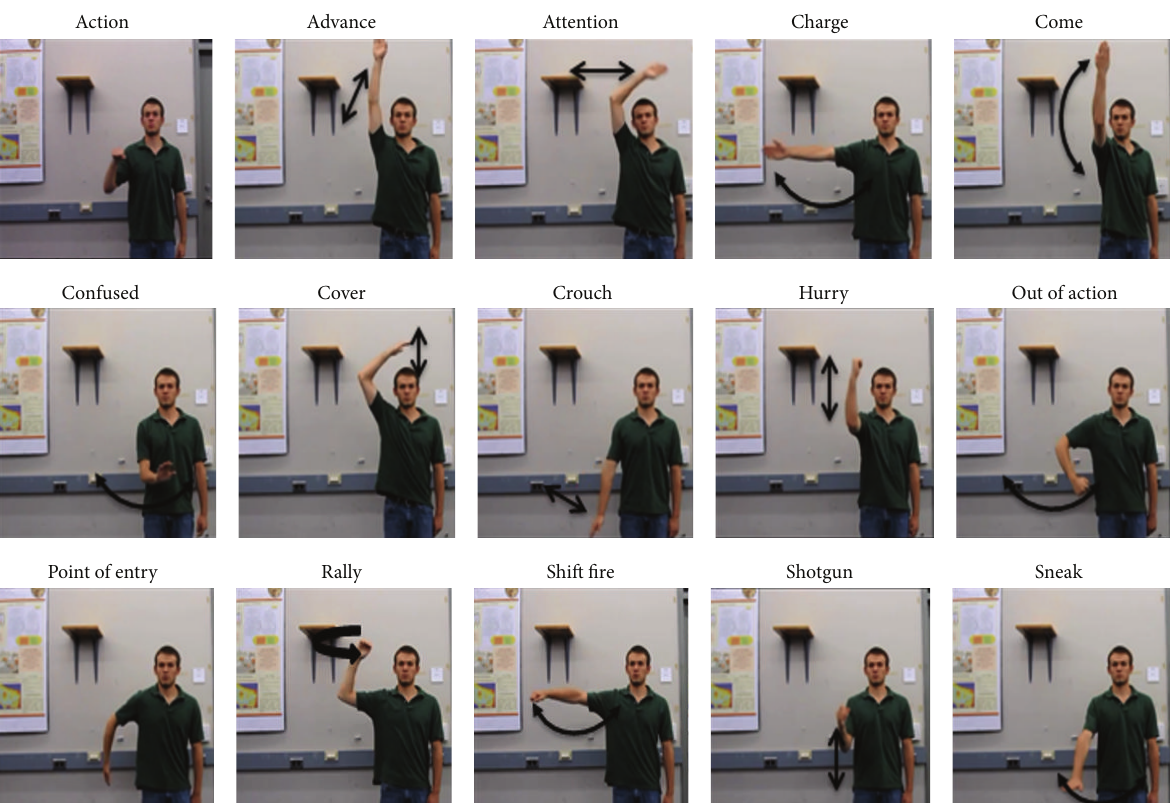
Figure 9: Gestures in Cornell